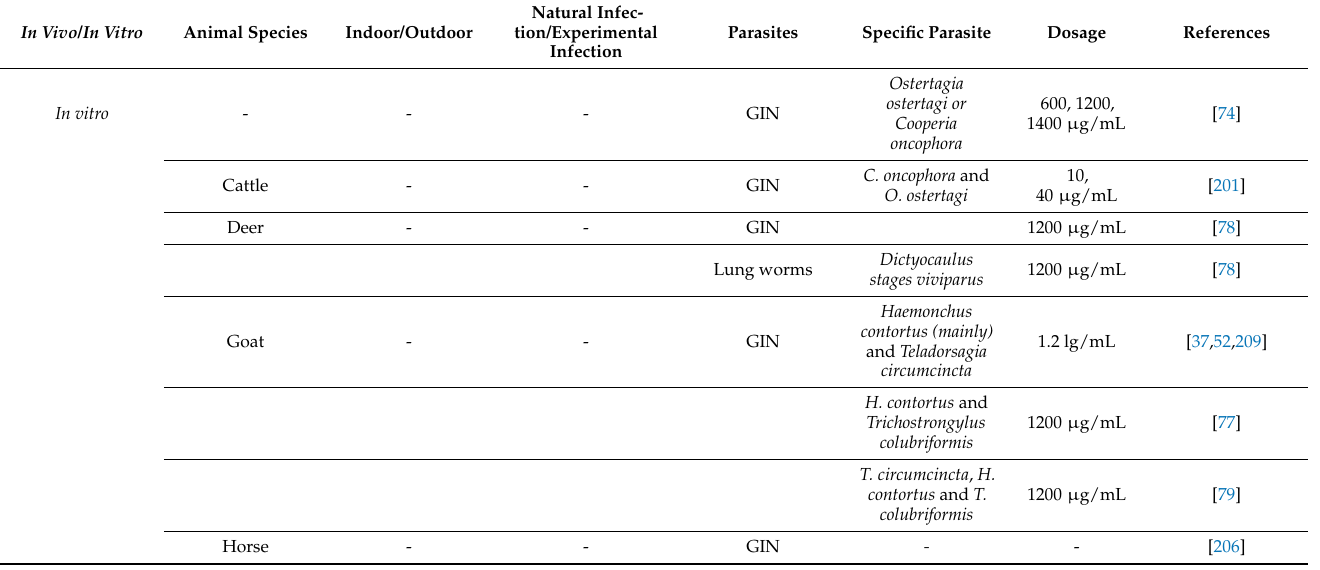
Table 10. Brief description of trials for the antiparasitic plant: Onobrychis viciifolia Scop. In Vivo / In Vitro Animal